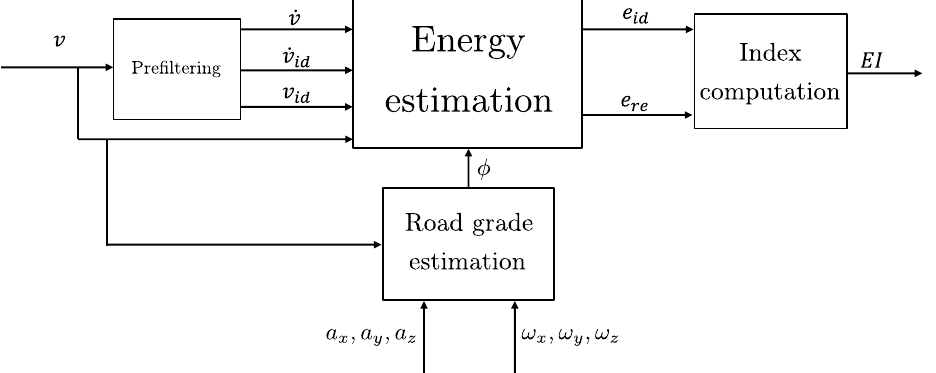
Figure 4. Block scheme of the Eco Index estimation